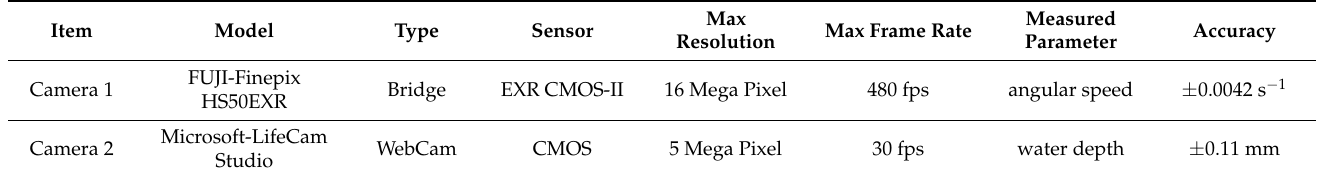
Table 2. Characteristics of Used